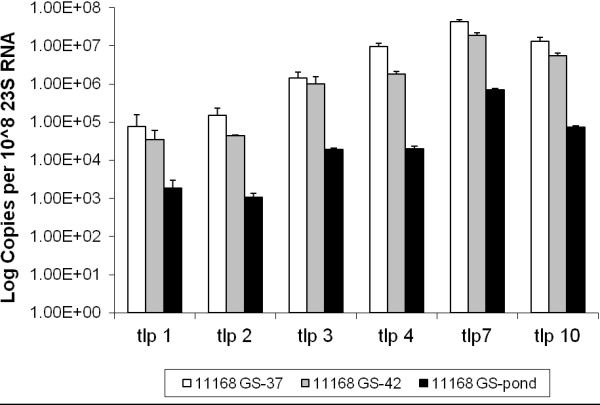
Expression of Group A tlp genes for C. jejuni strain 11168-GS. Relative gene expression profiles of Group A tlp genes for C. jejuni 11168-GS grown at 37°C, 42°C and maintained in pond water. Expression is standardised and the scale is shown in log (copies per 108 of 23 S RNA). 37: grown under laboratory conditions at 37°C, 42: grown under laboratory conditions at 42°C, pond: maintained in an environmental water source at room temperature, 22°C. Standard errors are shown as bars above the mean of a minimum of 3 independent PCR reactions.